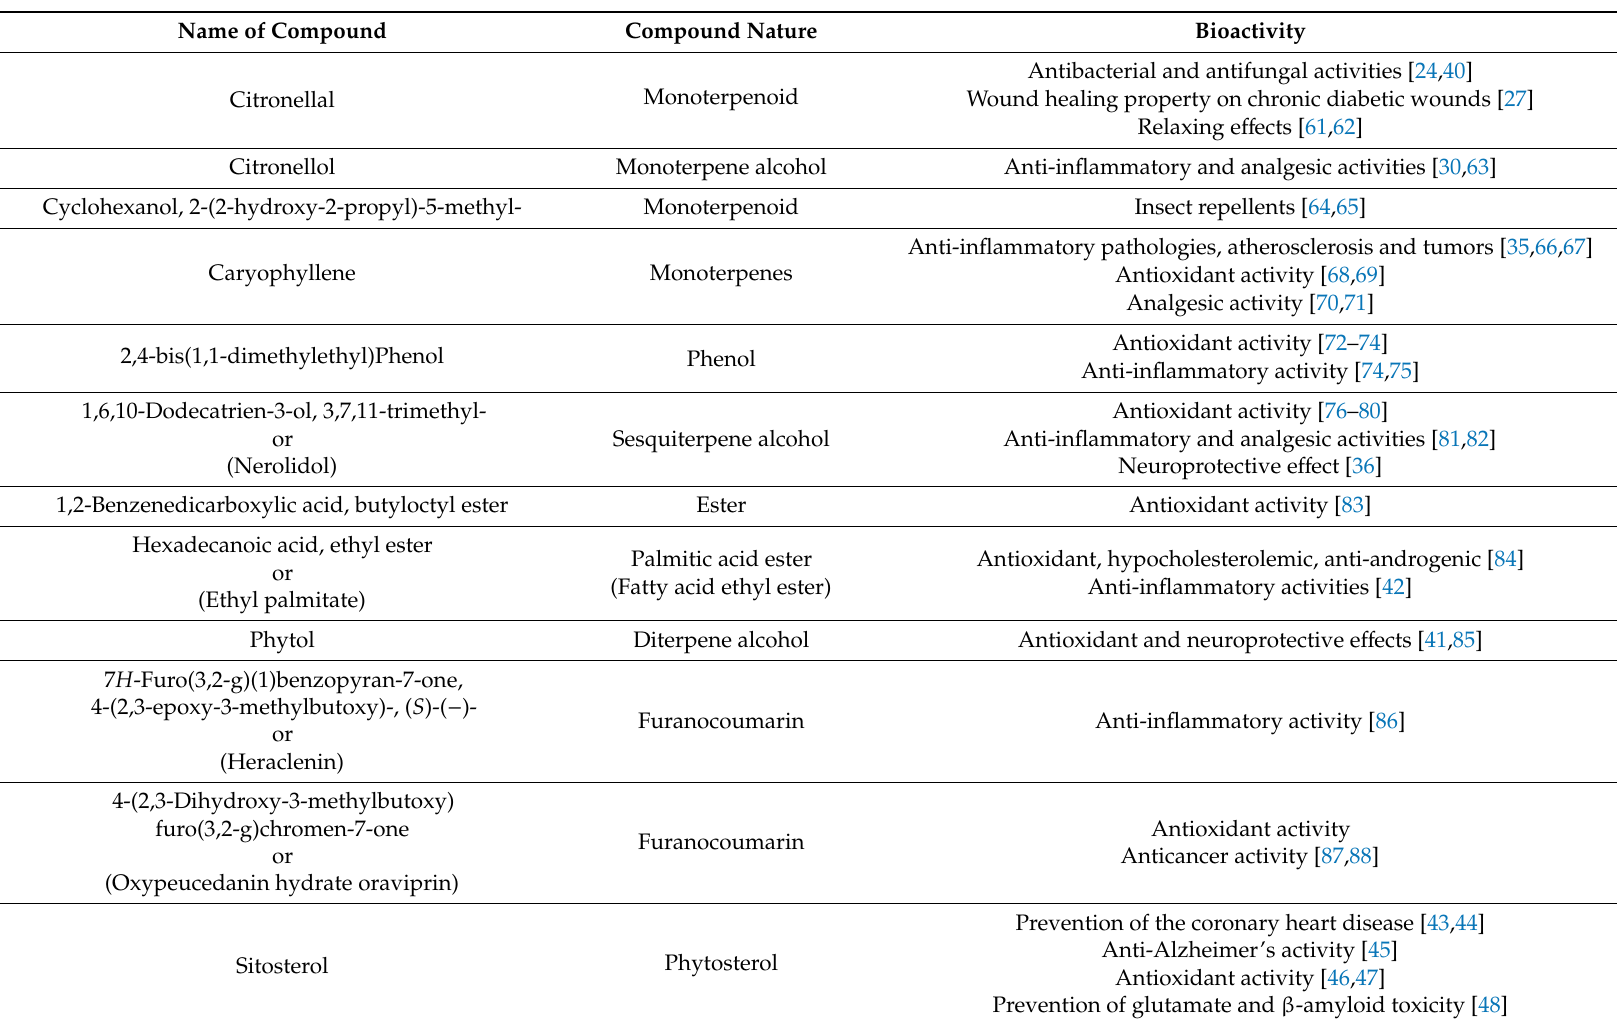
Table 6. Compound nature and bioactivity of phytochemical constituents in CHP and